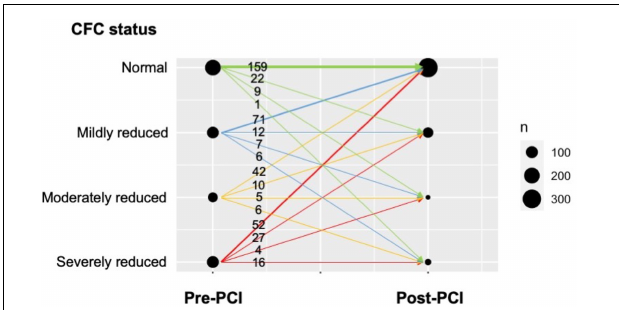
FIGURE 2 | Changes in CFC following PCI in the present cohort. The plot visualizes the number of patients with respect to pre-PCI CFC, post-PCI CFC, and the change. Numbers indicate the number of patients corresponding to the CFC changes, illustrated as the arrows. Thickness of the arrows and circles reflect the number of patients in each CFC change and each pre-/post-CFC categories, respectively. The majority of the patients improved their CFC status into normal after PCI, while the proportion was smaller in those with pre-PCI reduced CFC.